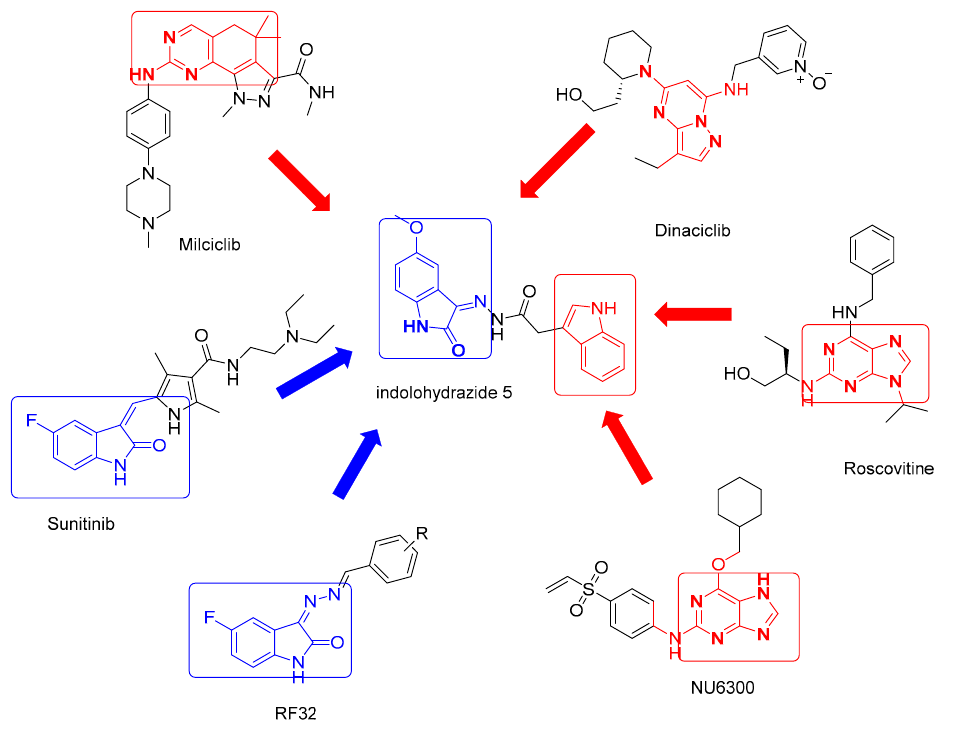
Figure 1. The structures of some potent CDK2 inhibitors.